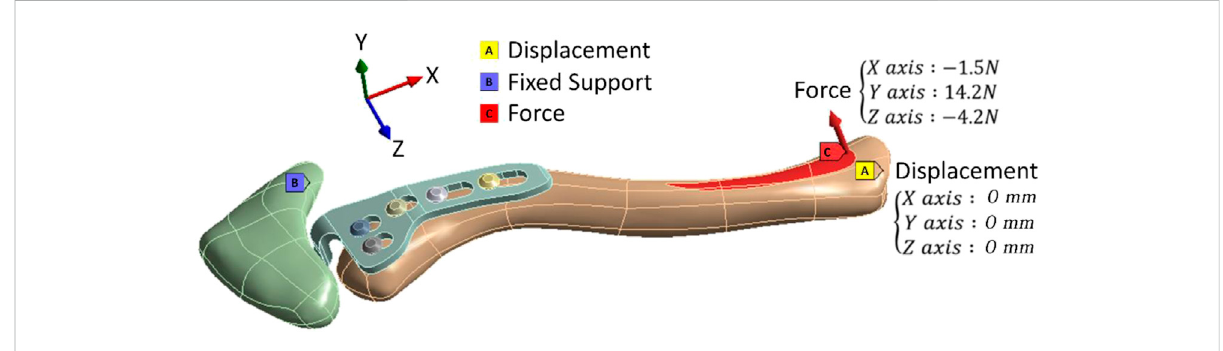
FIGURE 3 Boundary conditions and load conditions.